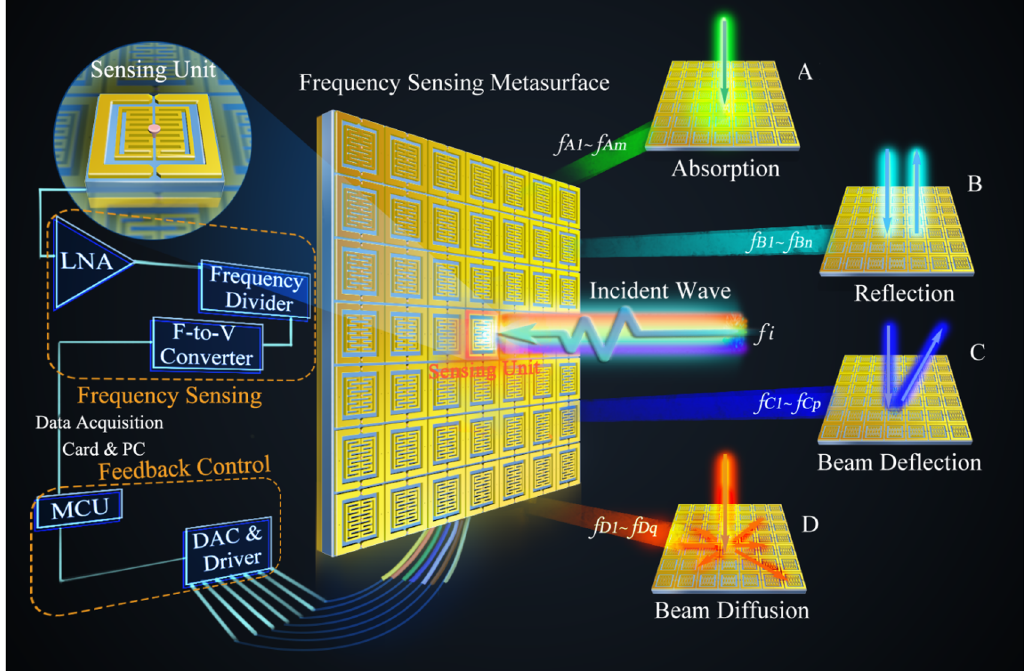
Figure 1: Schematic of the frequency-adaptive intelligent metasurface for self-adaptively precise control of spatial EM reflection spectrum. It consistsof